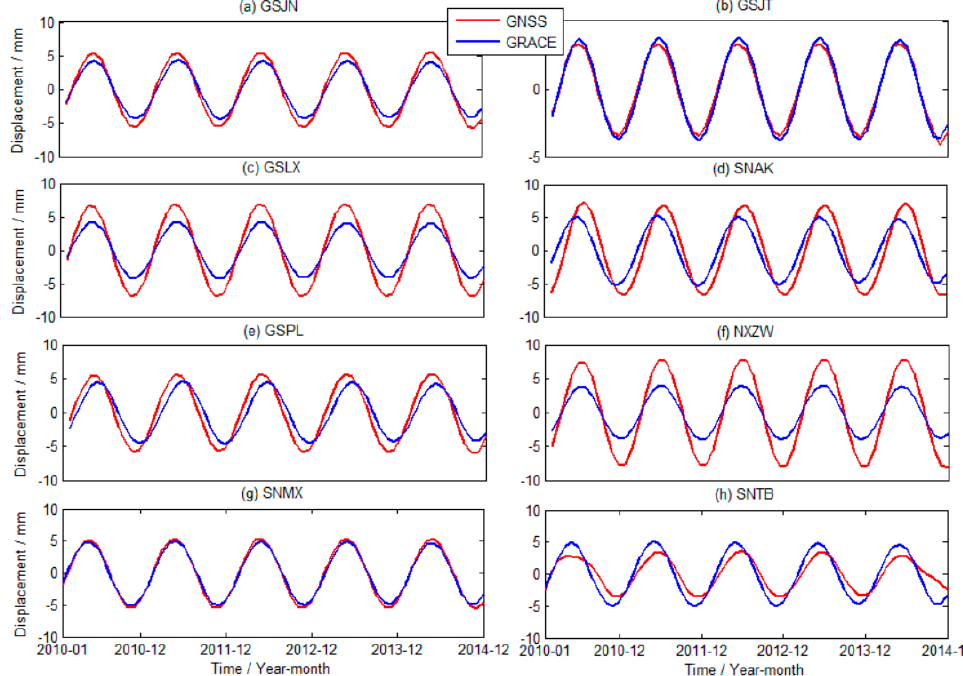
Figure 8. Comparison of GRACE and GAC total mass term time series with vertical time series from 8 CORS in SGN.